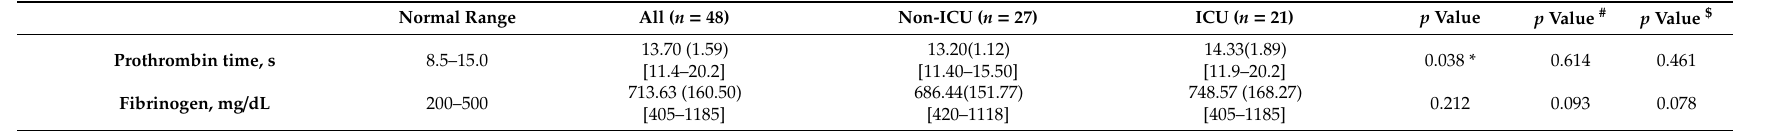
Table 3. Baseline coagulation function, biochemical and inflammation